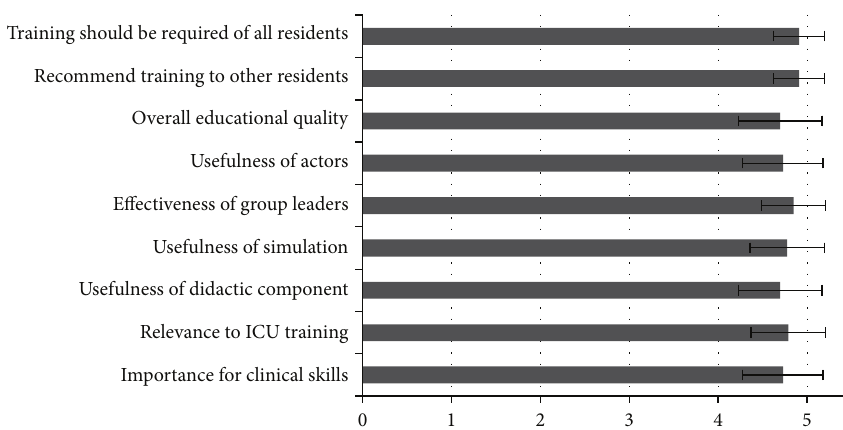
Figure 2: Resident satisfaction with intervention ( 𝑛 = 32 ; 1, Poor; 2, Fair; 3, Good; 4, Very Good; 5, Excellent). Error bars show standard deviation. ICU, intensive care